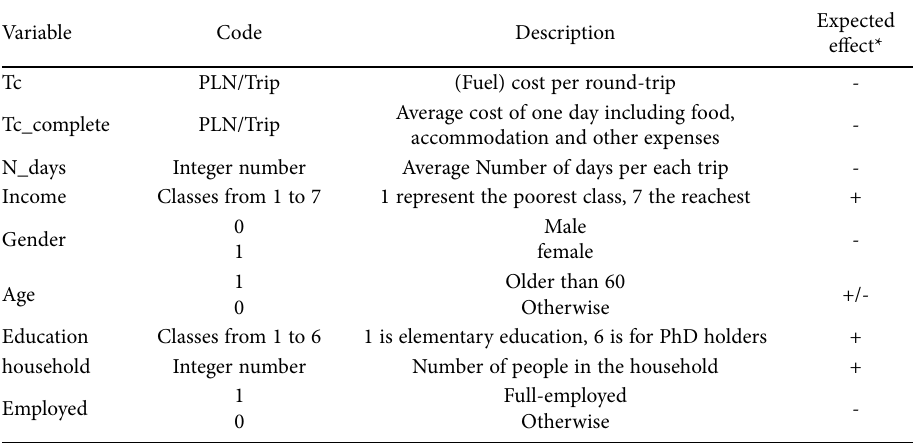
Table 3. List of the explanatory variables used in the travel cost.